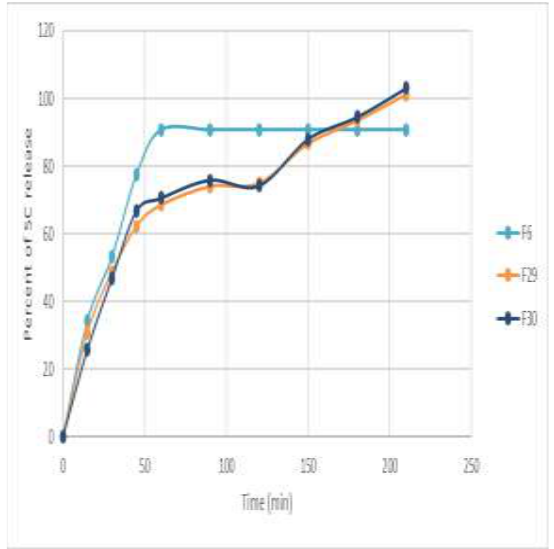
Figure 4.The percent release of SC with time in SFF (pH 6.8) at 37°C